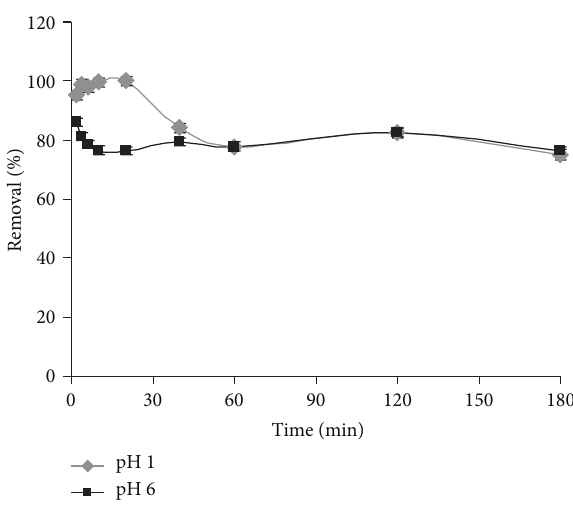
Figure 4: Effect of contact time on the removal of chromium by micelle-clay complex at pH 1 ( Q ) and pH 6 ( ◼ ). Initial concentration of Cr(VI) = 50mgL −1 , temperature = 25.0 ± 0.2 ∘ C, and adsorbent dosage = 5.0 gL −1 . Data represent averages of total-Cr triplicate measurements (AAS) ±